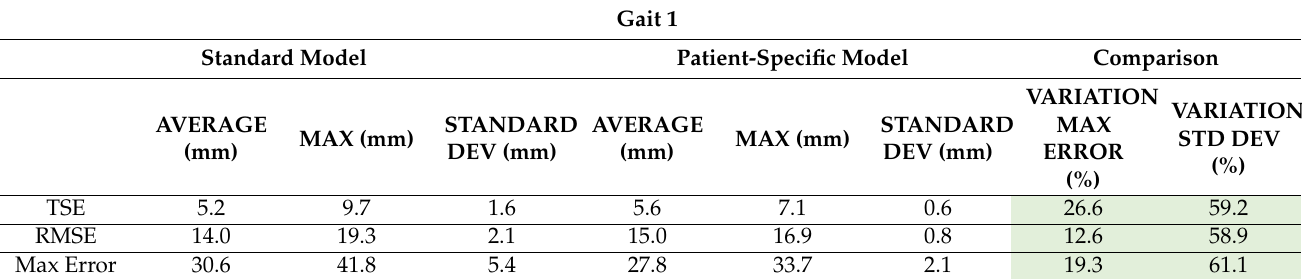
Table 1. Mean, Maximum value and Standard Deviation in Gait 1.